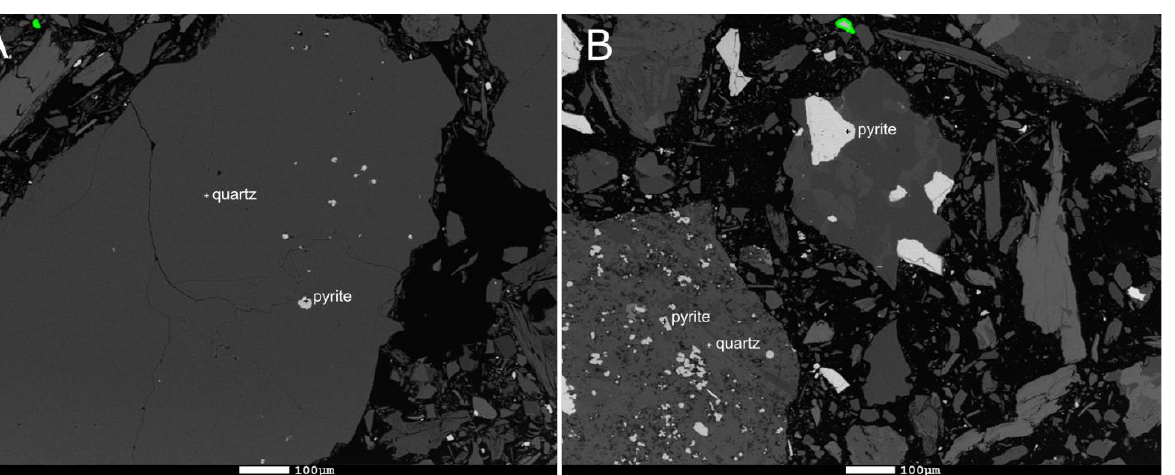
Figure 1. Backscattered electron images of the sample WR4 material before ( A ) and after ( B ) the HA2 extraction.